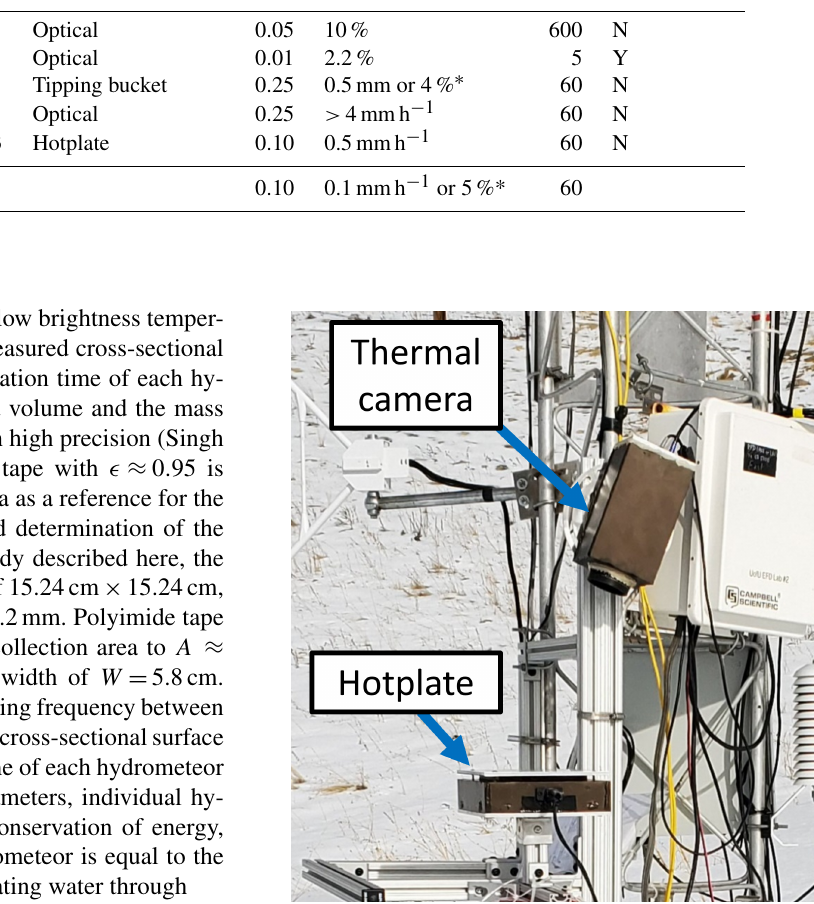
Figure 1. Photograph of the DEID during the Red Butte field ex- periment in Salt Lake City, Utah, with the thermal camera pointed at the hotplate